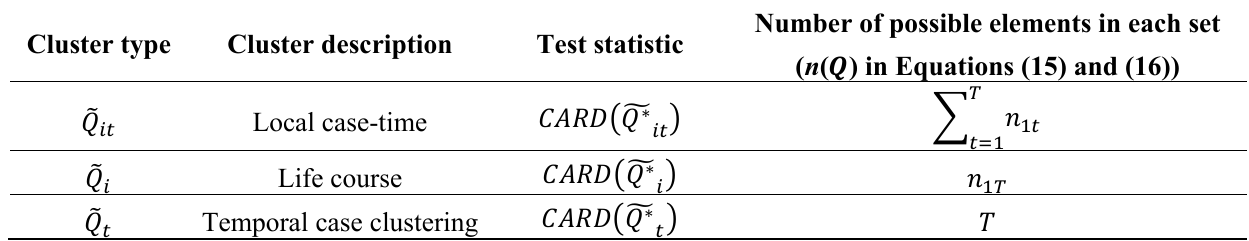
Table 3. Number of possible test statistics including those significant and not significant for each cluster type, using the duration-weighted tests. Here (cid:1866) extant in the study area at time t